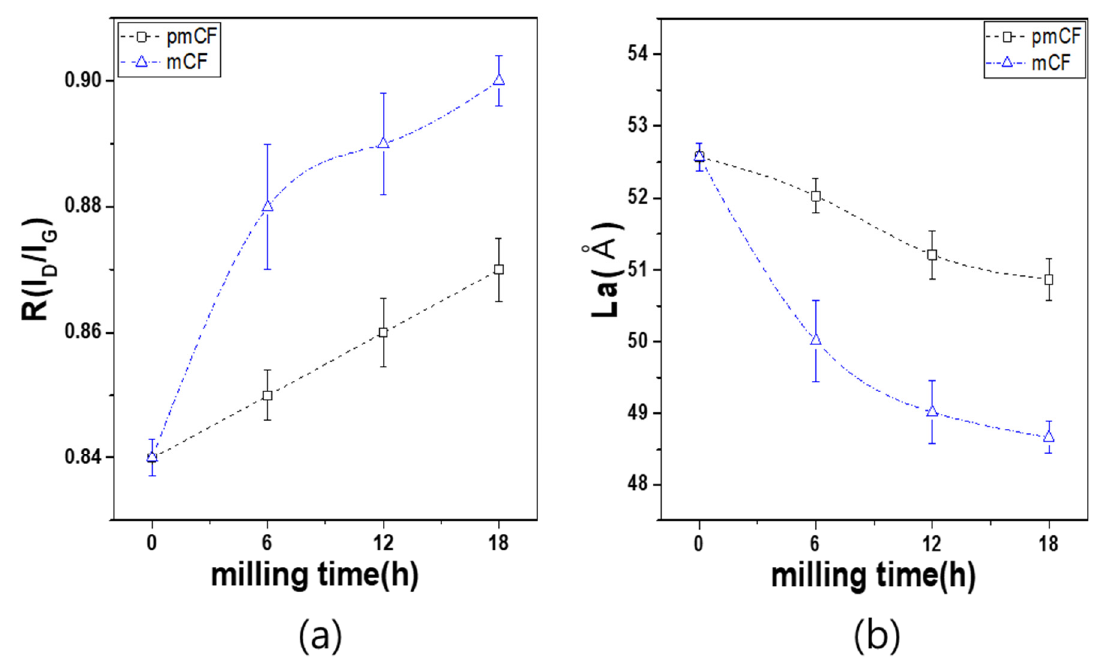
Materials 2021 , 14 , x FOR PEER REVIEW 10 of 13 Figure 6. Raman spectroscopic results of mPCFs depending on milling time. ( a ) R and ( b ) L a .